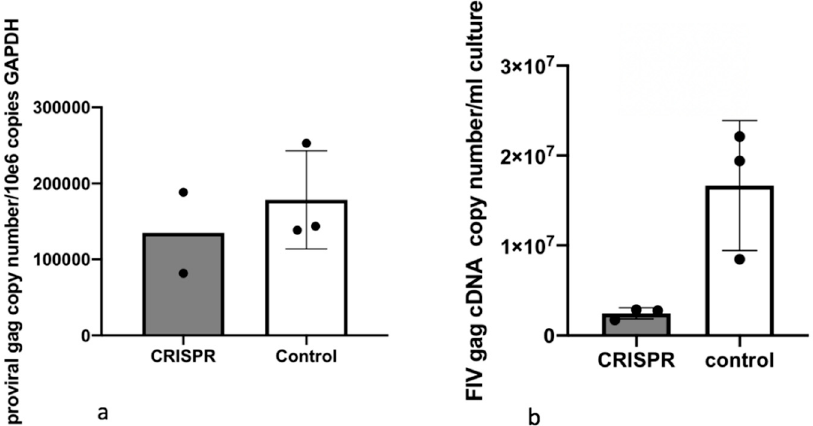
Figure 8. Experiment 2. ( a ) MCH5-4 cells selected for stable integration of the FIV CRISPR Cas9 editing tool and subsequently infected with FIVC (grey bar). One of the CRISPR-treated DNA samples was inadvertently lost during processing (grey bar, two data points). ( b ) Cell-free FIV is reduced in culture media derived from the cells treated with the CRISPR reagent relative to untreated control cells (6.8-fold reduction). The bar represents the mean while the error bars represent the standard deviation of three parallel experiments.